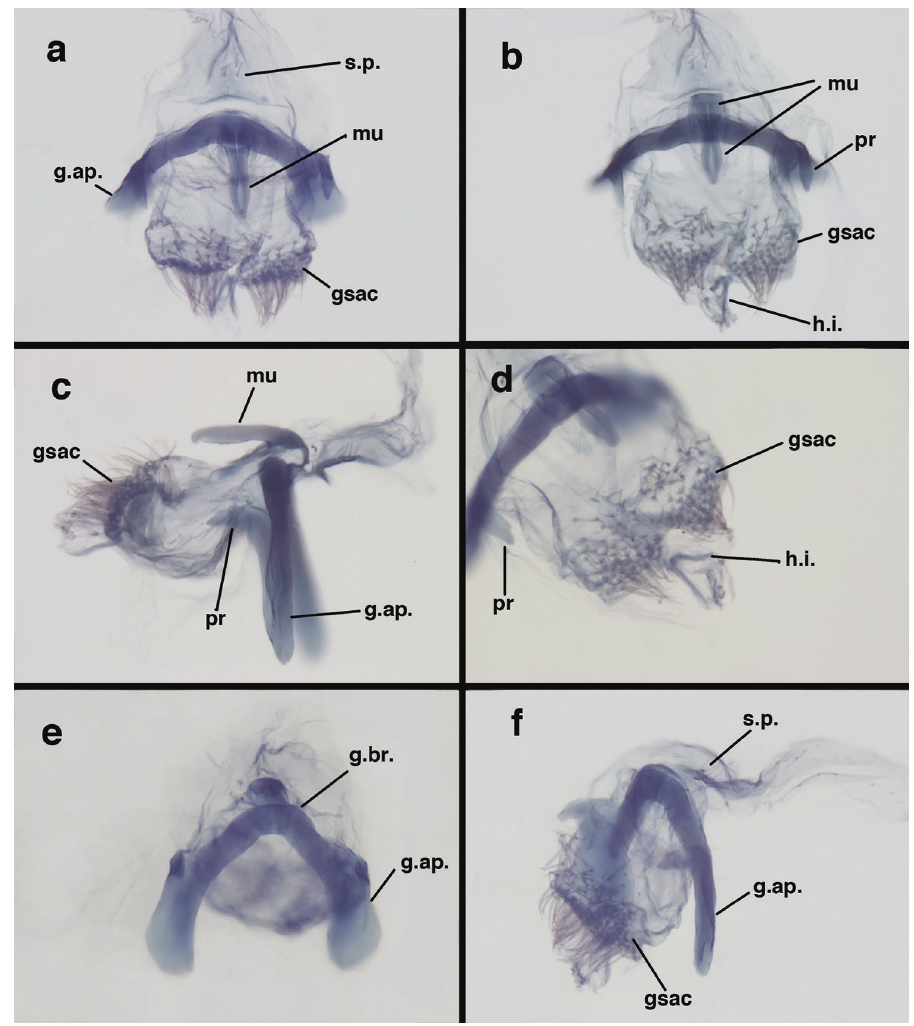
Figure 25. Ungla curimaguensis Sosa: Male genitalia, ( a, b ) gonarcal complex, dorsofrontal, with two slightly different positions ( c ) gonarcal complex, lateral ( d ) gonarcus (partial), dorsolateral, with hyp- andrium internum at base of gonosaccus ( e ) gonarcus, posterior ( f ) gonarcus, posterolateral. gsac gon- osaccus g.ap. gonarcal apodeme g.br. gonarcal bridge h.i. hypandrium internum mu mediuncus pr unarticulated process on frontal margin of gonarcal apodeme s.p. setose subanal plate (all: Venezuela, Aragua, Rancho Grande,